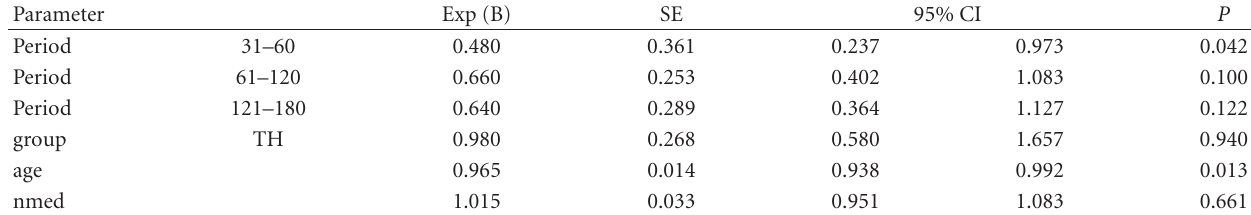
Table 10: Results from GEE model for ED